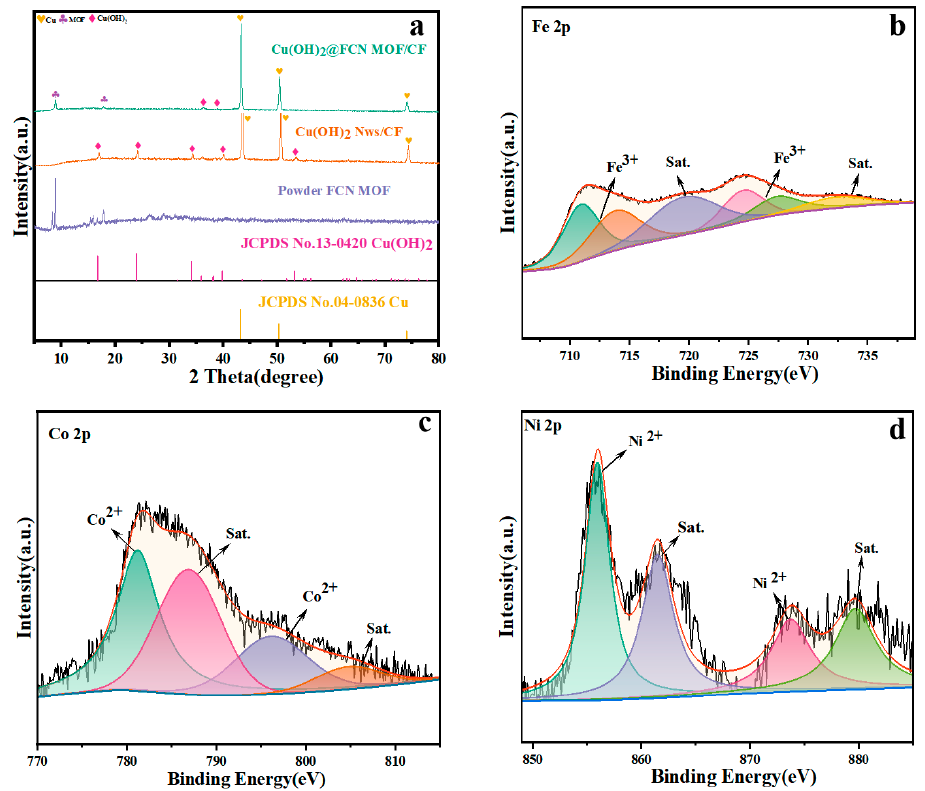
Figure 2. Structure and chemical states characterizations. ( a ) PXRD pattern of Cu(OH) 2 @FCN MOF/CF, high-resolution XPS spectra of ( b ) Fe 2p, ( c ) Co 2p and ( d ) Ni 2p for the Cu(OH) 2 @FCN MOF/CF catalyst.